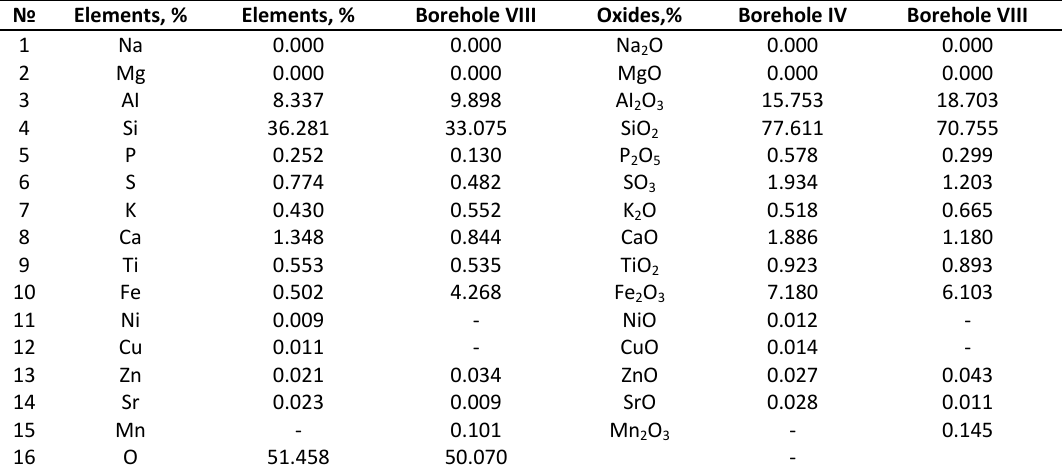
Table 4. The mineral composition of coal ash of Tavan tolgoi